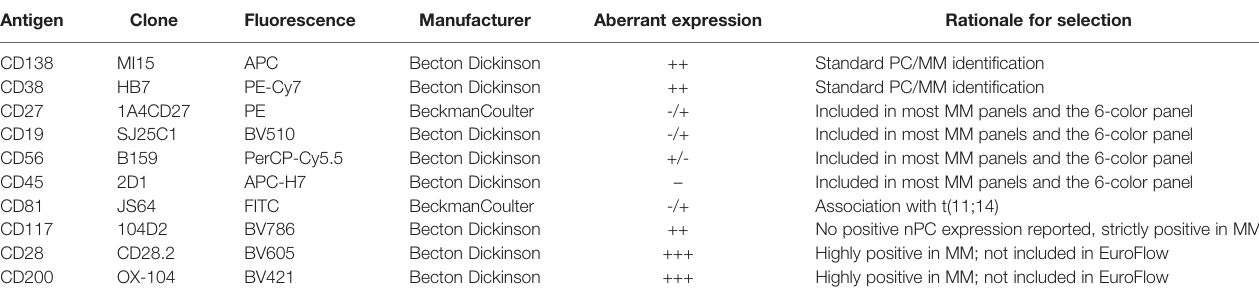
TABLE 1 | Key data for the ten investigated antigens and utilized fl